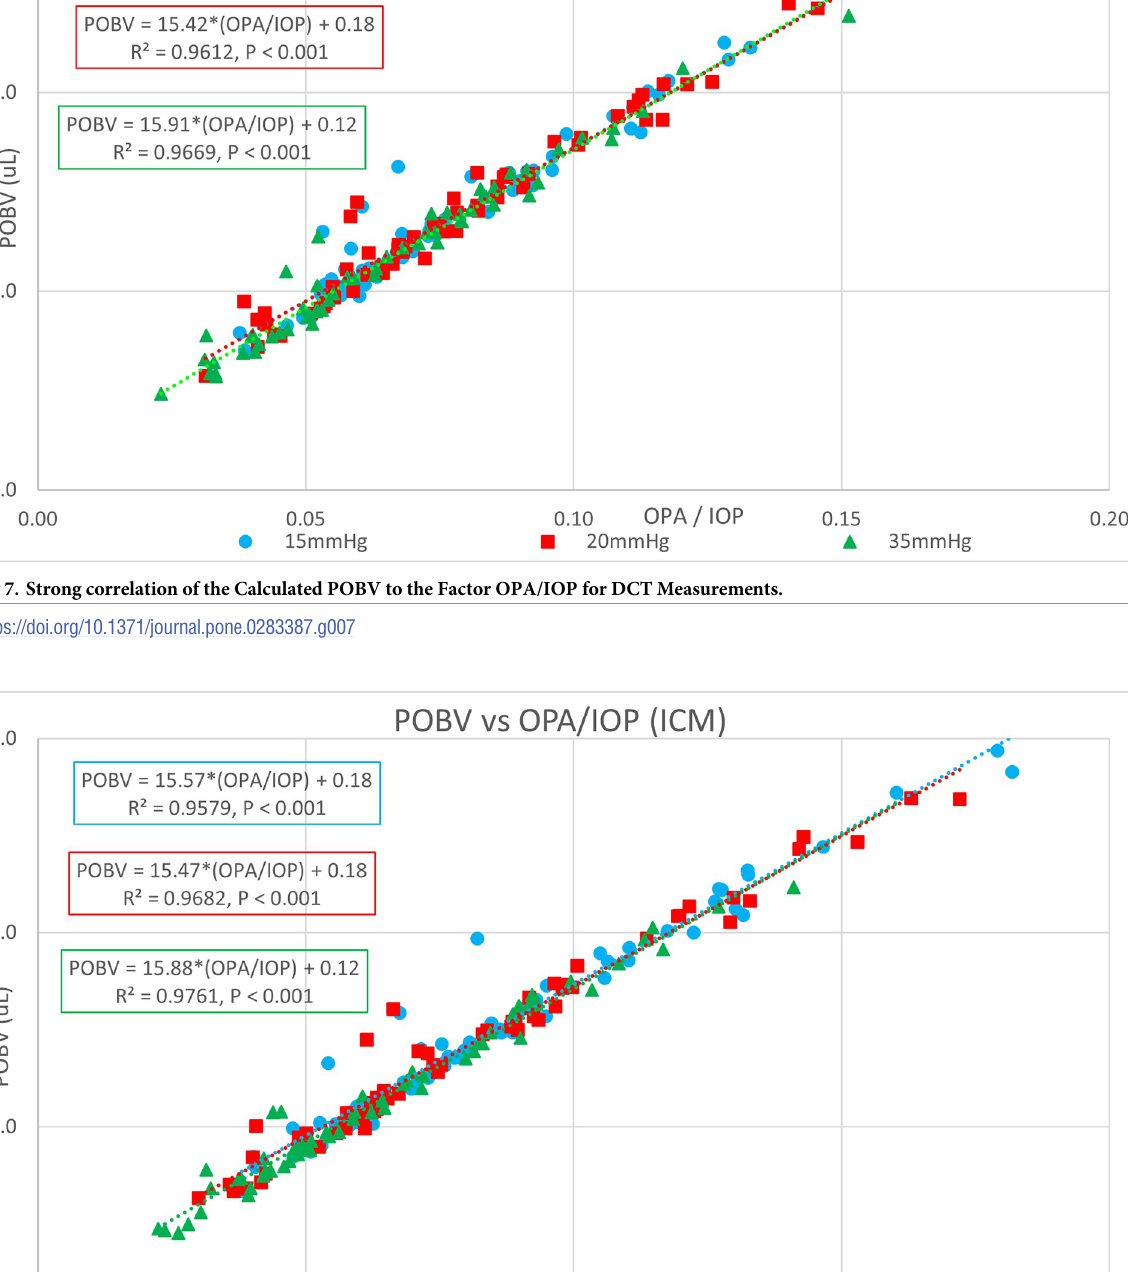
PLOS ONE | https://doi.org/10.1371/journal.pone.0283387 March 23, 2023 8 /